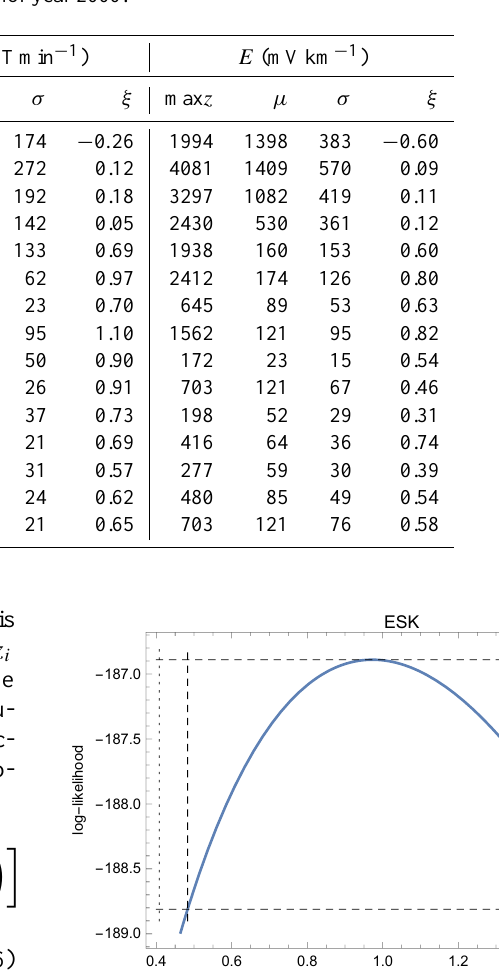
Table 1. The magnetic latitude, number of years ( N ), maximum of block-maxima z (nTmin − 1 ), the estimated parameters µ (nTmin − 1 ), σ (nTmin − 1 ), and ξ for each analysed station. Note that UPV is the combined series from the LOV and UPS stations. The magnetic latitudes have been calculated using the 11th generation IGRF coefficients for year 2000.